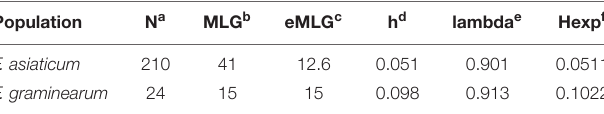
TABLE 4 | Genotypic diversity of F. asiaticum and F. graminearum mitogenomes basing intron regions. Population N a MLG b